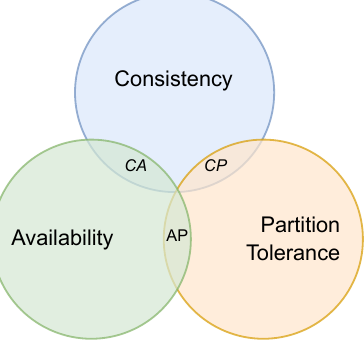
Figure 1. CAP theorem representation.